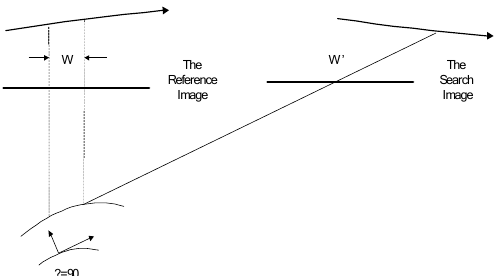
Figure 3. Image selection or exclusion based on the terrain slope and the sensor geometry. The size of the corresponding correlation window in the search image depends on the angle θ between the normal vector of the local object surface and the corresponding imaging